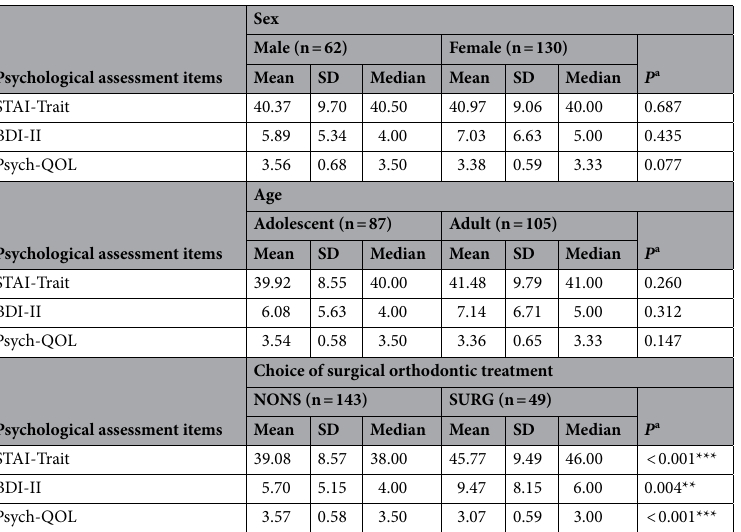
Table 1. Comparison of psychological assessments between groups classified by sex, age, and choice of surgical orthodontic treatment. NONS non-surgical orthodontic treatment, SURG surgical orthodontic treatment, STAI State-Trait Anxiety Inventory, BDI-II Beck Depression Inventory-II, Psych-QOL psychological domain of the World Health Organization Quality of Life 26, SD standard deviation. a Mann–Whitney U test. ** P < 0.01; *** P < 0.001.